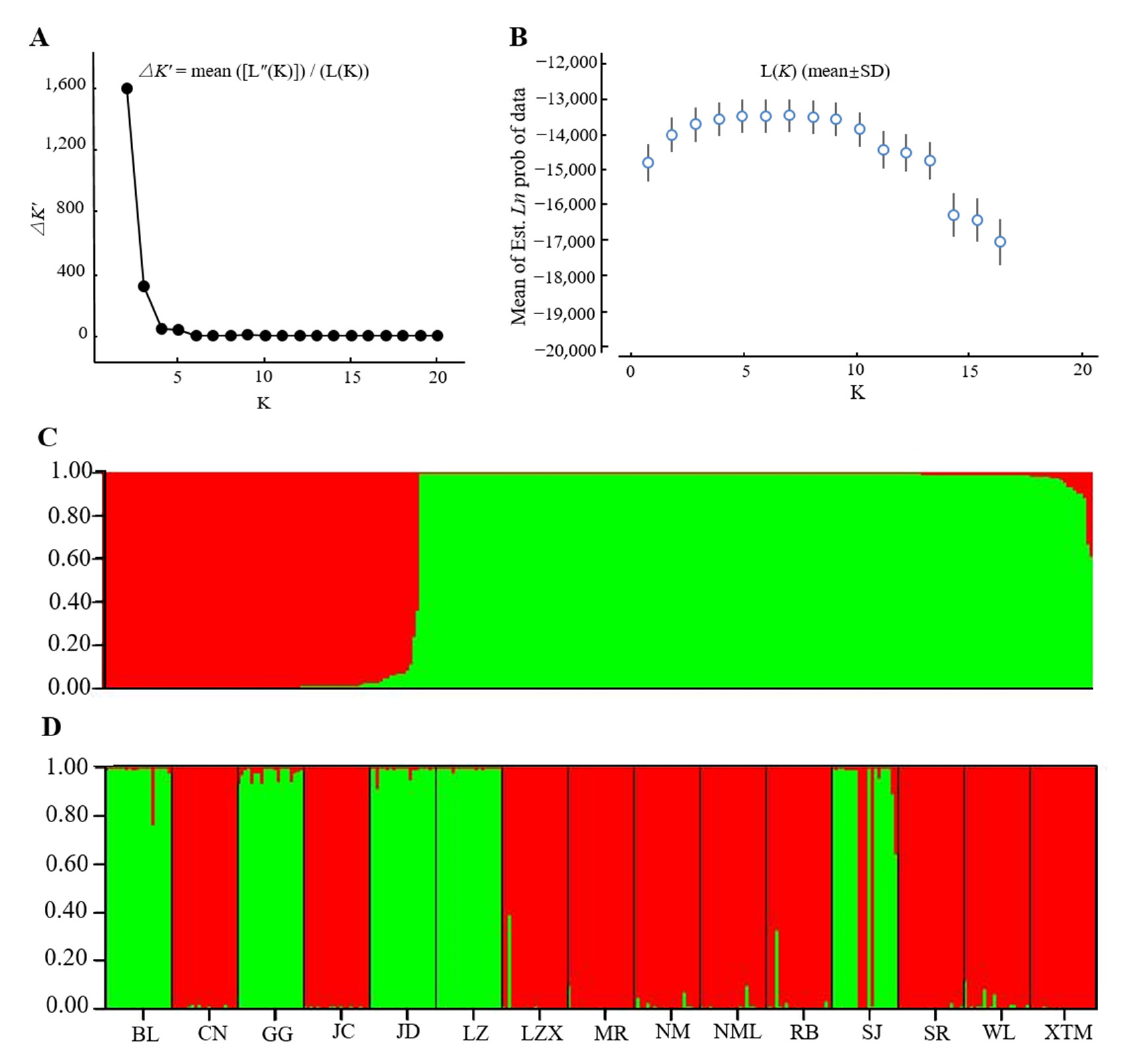
Figure 4. Bayesian-model-based clustering STRUCTURE analysis of 300 individuals of S. moorcroftiana. ( A ) △ K values for different numbers of clusters ( K ); ( B ) mean log-likelihood (Ln( K ) ± SD) against the number of K ; ( C , D ) estimated population structure of 300 S. moorcroftiana individuals on K = 2; ( C ) bar plot sorted by Q-value in a single line; ( D ) bar plot grouped by population ID in multiple lines.